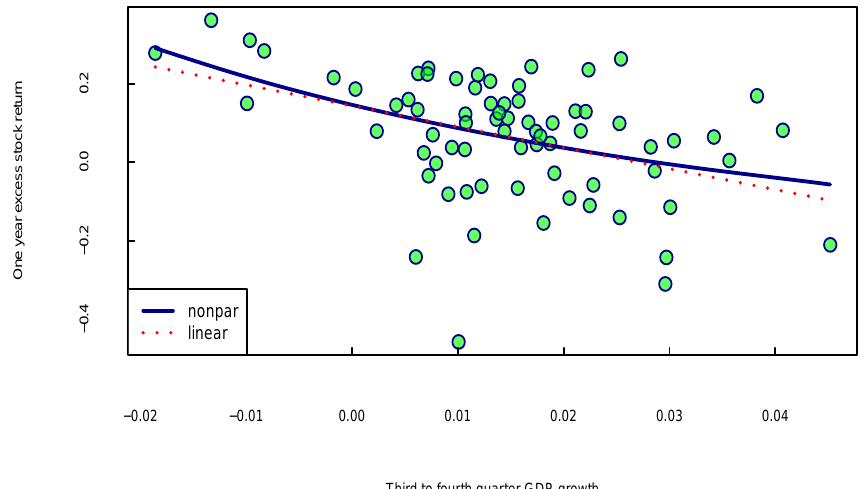
Figure 4. Risk-free benchmark. Relation between excess stock returns and third to fourth quarter GDP growth. Estimated nonparametric function ˆ m (dark blue line), linear model (dotted red line), observations (green balls). The sample period is 1947–2020.